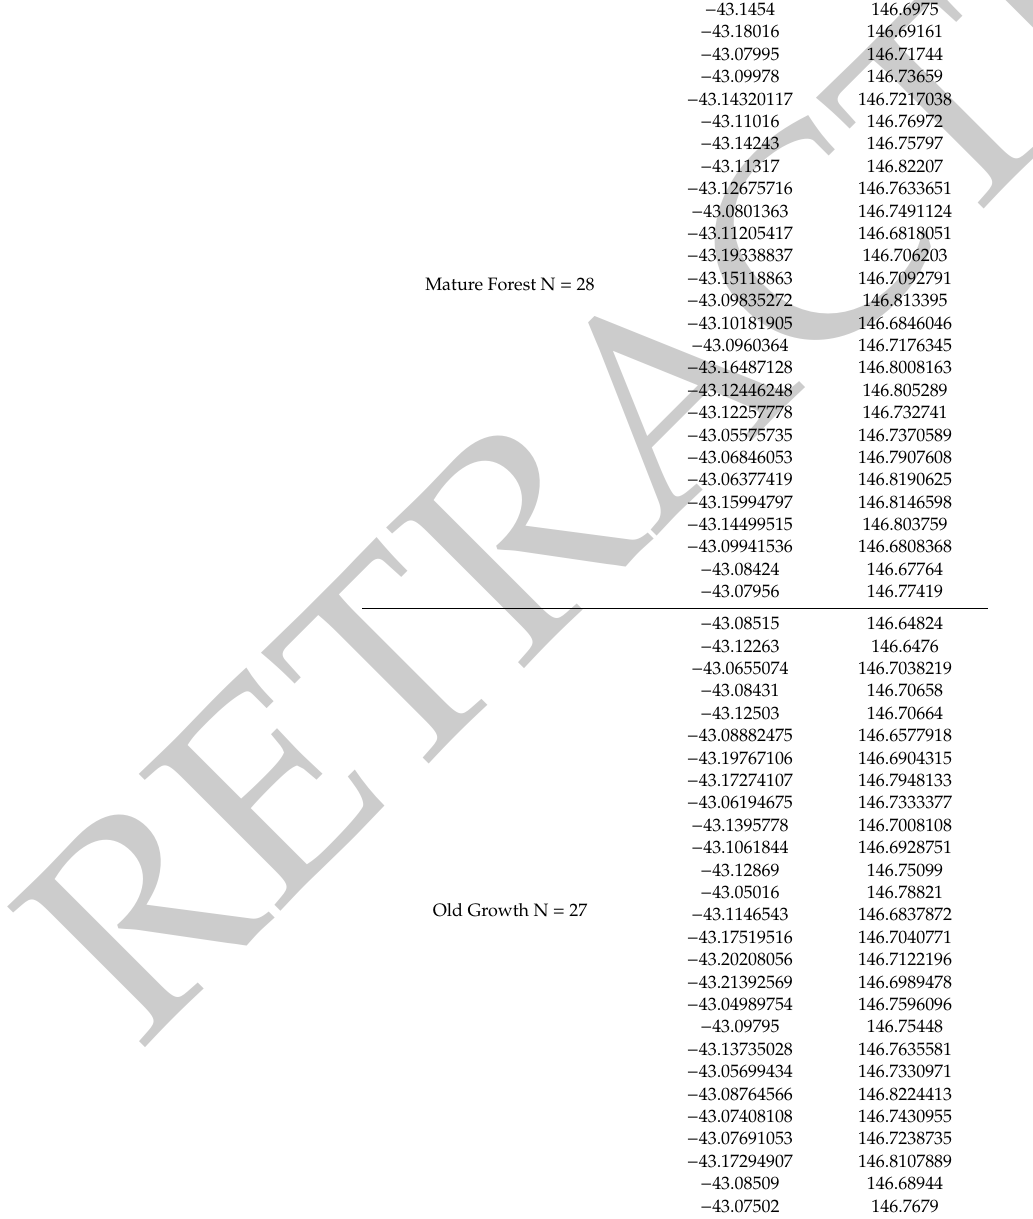
Table A1. List of sample points with coordinates and forest type. Figure